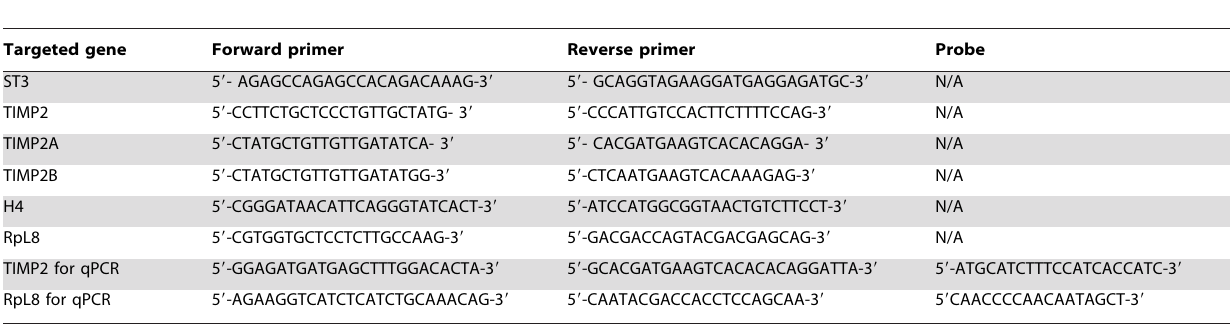
Table 1. Primers for RT-PCR and